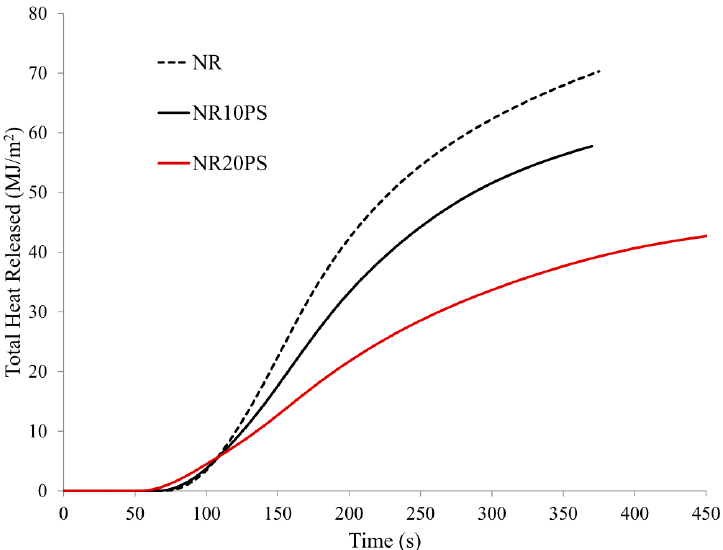
Figure 11. Total heat release (THR) curves of NR rubber composites containing pure straw filler. The THR (39%), EHC (43.7%), FIGRA (59.6%), and MARHE (47.6%) parameters were also significantly